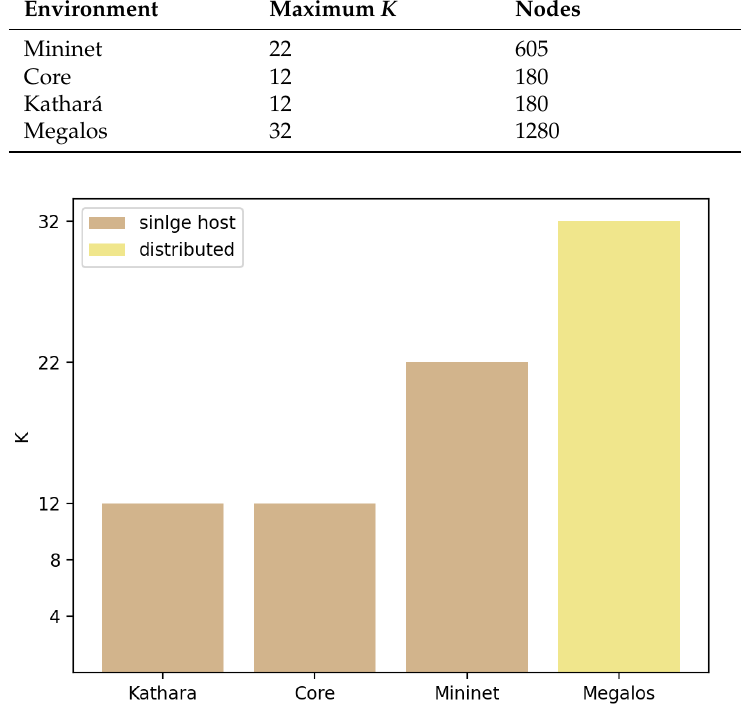
Figure 5. Performance of environments as a function of k